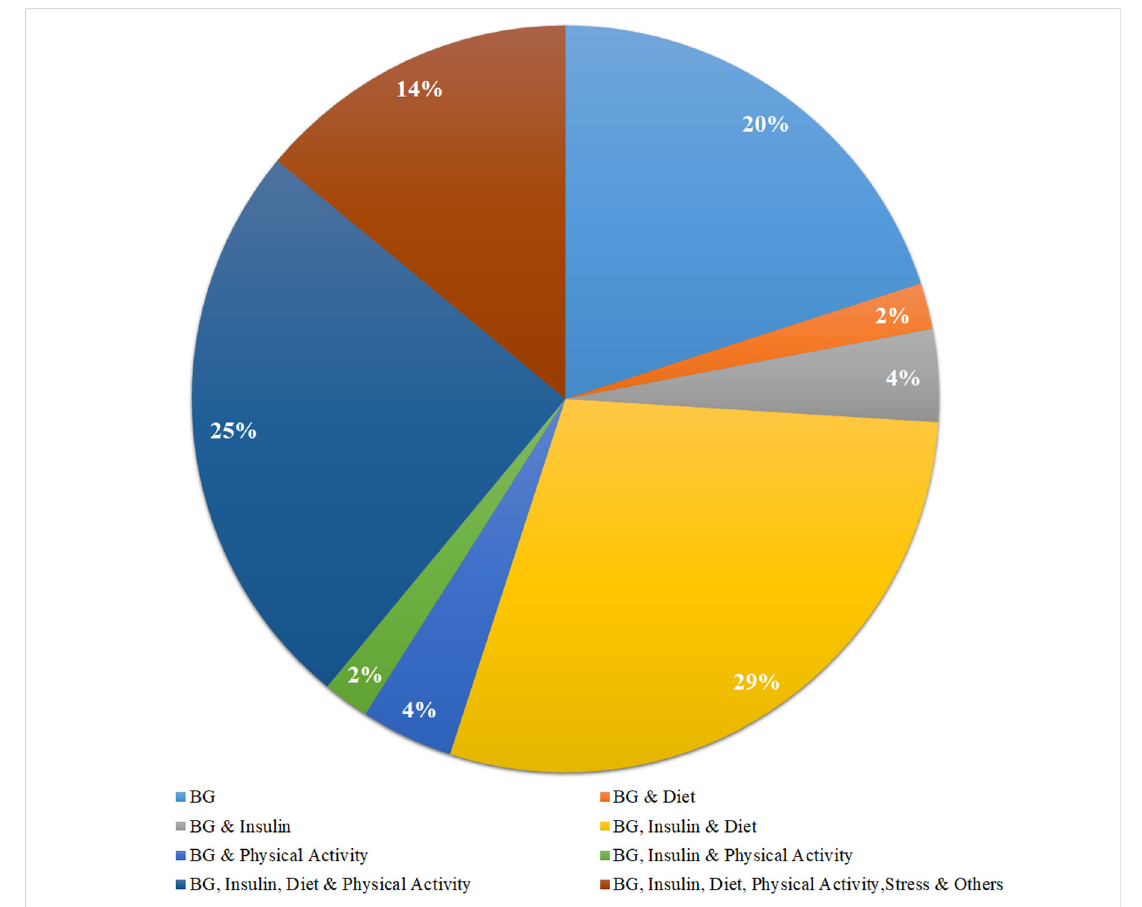
Figure 9. Input Feature set contribution in recent studies for diabetes